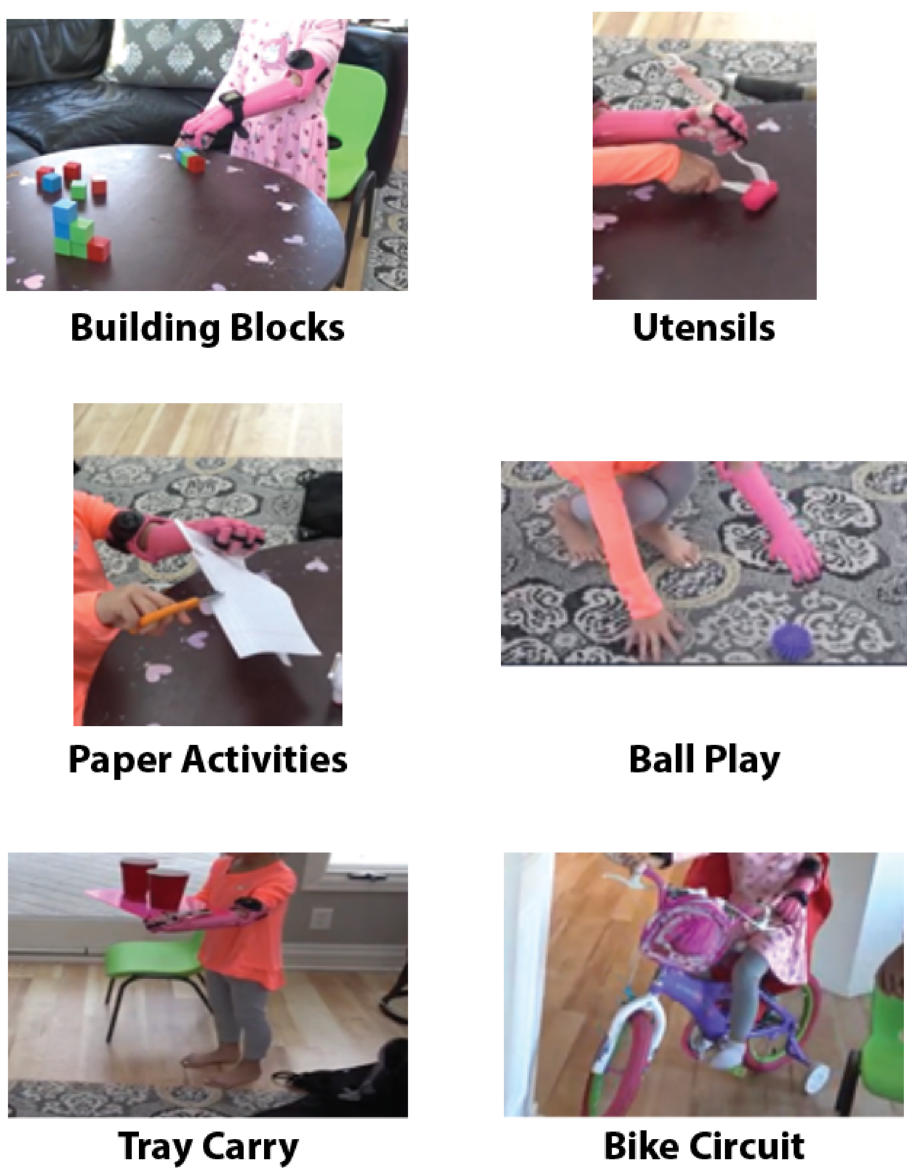
Figure 4. Pictures of the activities completed in the Home Intervention Program including Block Building, Utensils, Paper Activities, Ball Play, Tray Carry, and Bike